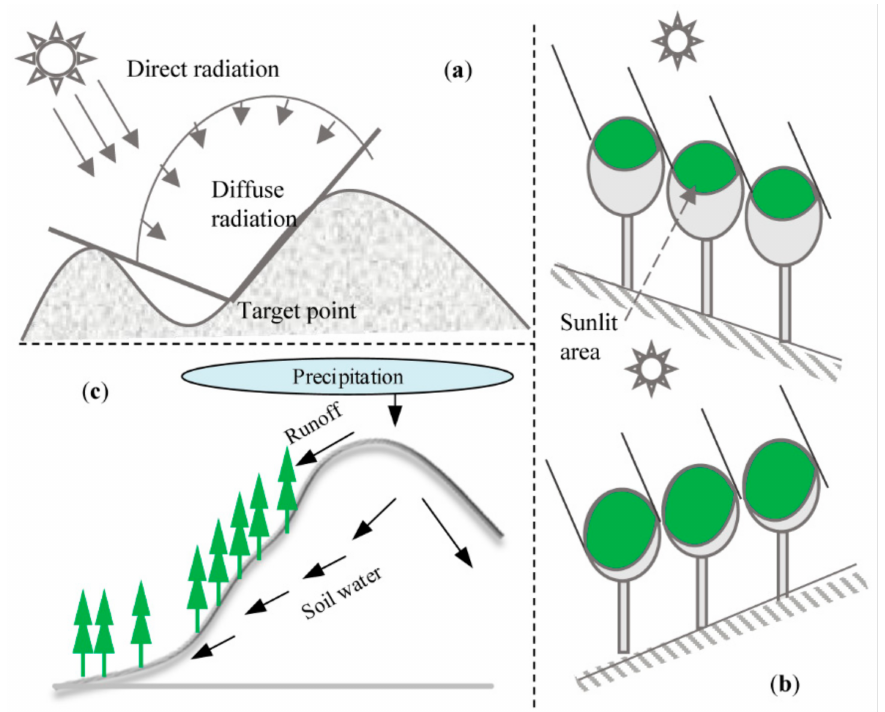
Figure 7. Effect of topography on incoming solar radiation ( a ), canopy shadow ( b ), and water ( c ) over mountainous